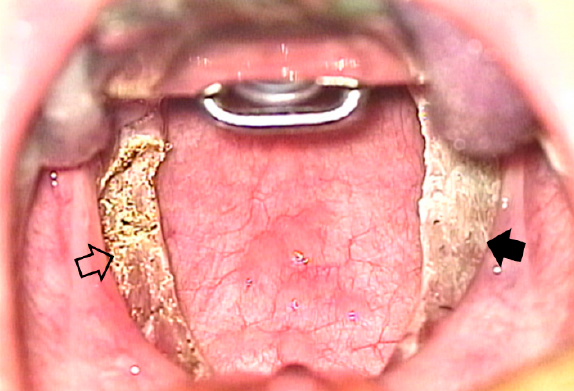
Figure 3. Surgical view after coblation and electrocautery tonsillectomy. Coblation and electrocautery tonsillectomy are performed on the right (solid arrow) and left (open arrow) tonsils, respectively.